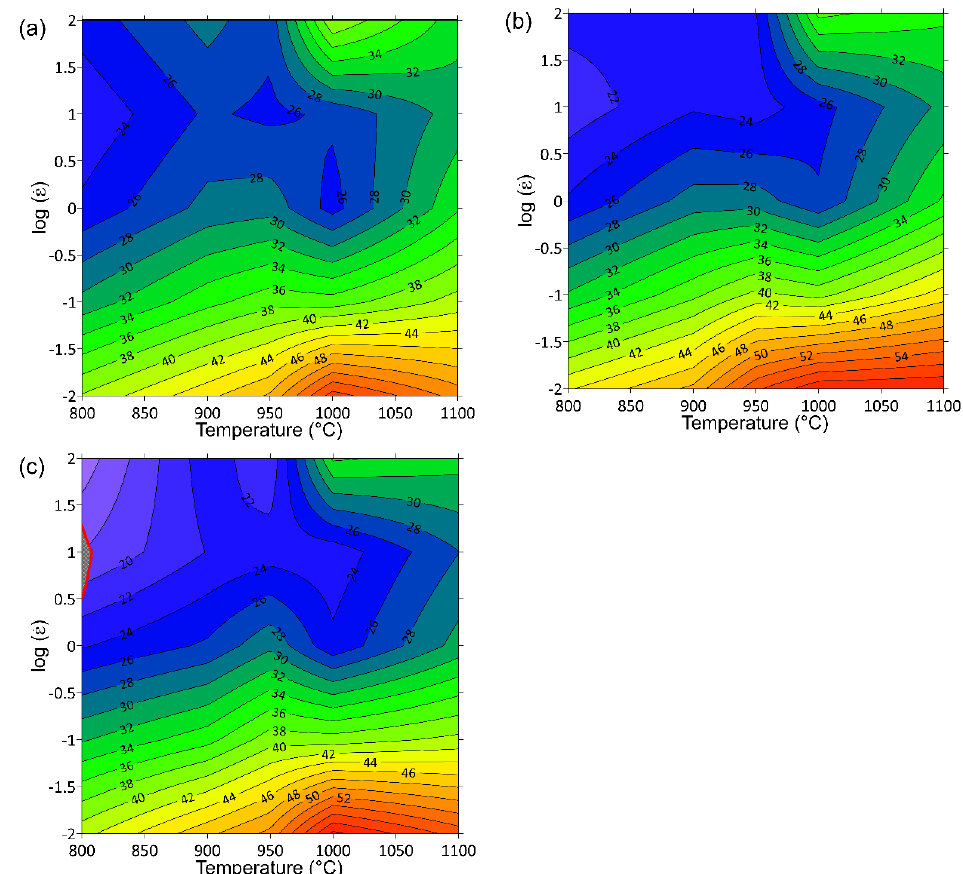
Figure 8. Processing maps for Ti-1023 alloy developed for true strains of ( a ) 0.2, ( b ) 0.6, and ( c ) 1. The distribution of criterion ξ shows that the flow instability (a negative values of ξ ) appears only in a small area for the true strain of 1 (Figure 8c), at strain rates from 3 s − 1 to 6 s − 1 and deformation temperatures in the range of 800–810 °C. This means that the flow behavior of Ti-1023 is quite stable under the investigated deformation conditions. It should also be emphasized that the noted instability area is characterized by the low efficiency of power dissipation (21–17%), and it is also one of the reasons not to recommend the hot deformation under parameters corresponding to this range of processing parameters. Based on the distribution of flow instability parameter ξ as well as the η parameter, the processing windows describing the most useful combinations of hot deformation parameters can be determined. First of all, a domain should be distinguished (first processing window), with peak values of the efficiency of power dissipation in the range from 56% to 60%, in the temperature range from 950 °C to 1050 °C and low ( ≥ 0.04 s − 1 ) strain rates. The second processing window is located in the domain at the temperature range of 980–1050 °C and strain rates ≤ 60 s − 1 with peak value of parameter η in the range of 38–34%. The hot workability of Ti-1023 alloy can be improved by the application of deformation conditions corresponding to the proposed process windows. 3.5. The Microstructure Evolution Figure 9 presents the microstructures of the specimens deformed in compression under various deformation temperatures and strain rates. The microstructure of the material deformed at temperature of 800 °C and strain rate of 0.01 s − 1 (Figure 9a) is characterized by fine α phase precipitates, still remaining in the microstructure of the original β grains. An increase in the deformation temperature to 1000 °C (Figure 9b) leads to the complete dissolution of the α phase precipitates and to the effects associated with the DRV. The grain growth and deformation of the original β grains as well as the subsequent formation of the substructure as a result of deformation are observed. Such changes in the microstructure can be associated with superplasticity of large grains at low deformation strain rates, which was also reported in other studies [49,51]. In addition, the high value of parameter η (56–60%) indicates better workability during such deformation conditions as a result of a greater power dissipated due to the microstructural changes. The microstructure of the material deformed in the β phase region at temperature of 900 °C and strain rate of 1 s − 1 is presented in Figure 9c. An increase in strain rate causes the original β grains to elongate in the direction of the material flow and the β grains boundaries are serrated. This effect is associated with DRV and affects the further nucleation of grains at the prior β phase boundaries, which is also visible in Figure 9c and is typical for DRX. At the highest deformation temperature and highest strain rate (Figure